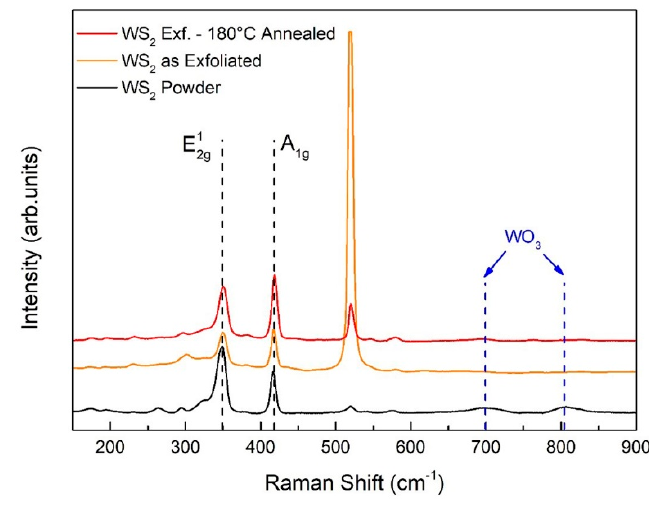
Figure 6. Raman spectra of WS 2 bulk powder, WS 2 as-exfoliated and WS 2 flakes post-annealed at 180 °C.